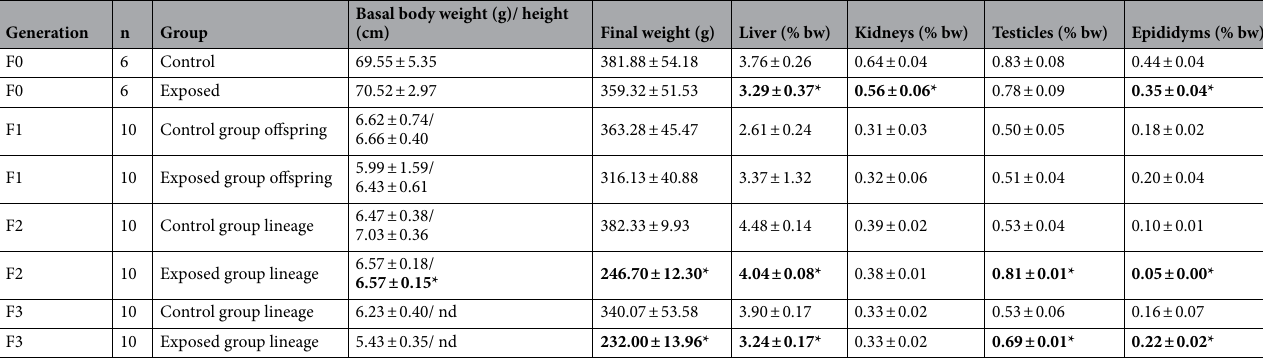
Table 1. Body weight and organ relative weight over generations in males. (*) Statistically significant differences between control and arsenic exposed group (mean ± standard deviation) compared